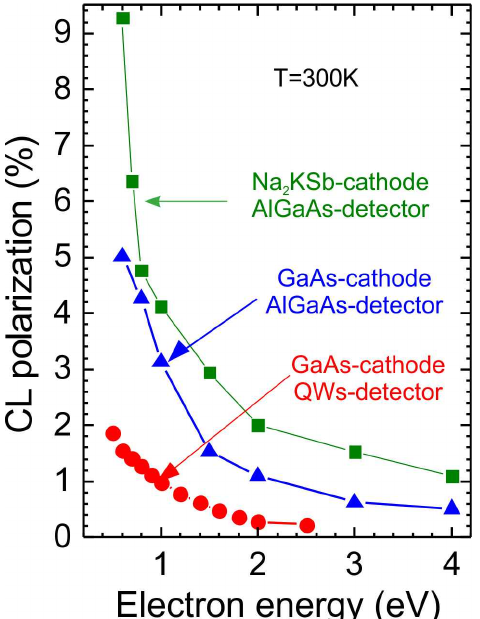
Figure 6. Dependence of the cathodoluminescence CP degree on the energy of injected spin-polarized electrons for the GaAs cathode and QWs detector (red circles) and Al 0.11 Ga 0.89 As detector (blue triangles) compared with the Na 2 KSb photocathode and Al 0.11 Ga 0.89 As detector (green squares). The electron energy is proportional to the bias applied between the anode and cathode, and elementary charge of electron.